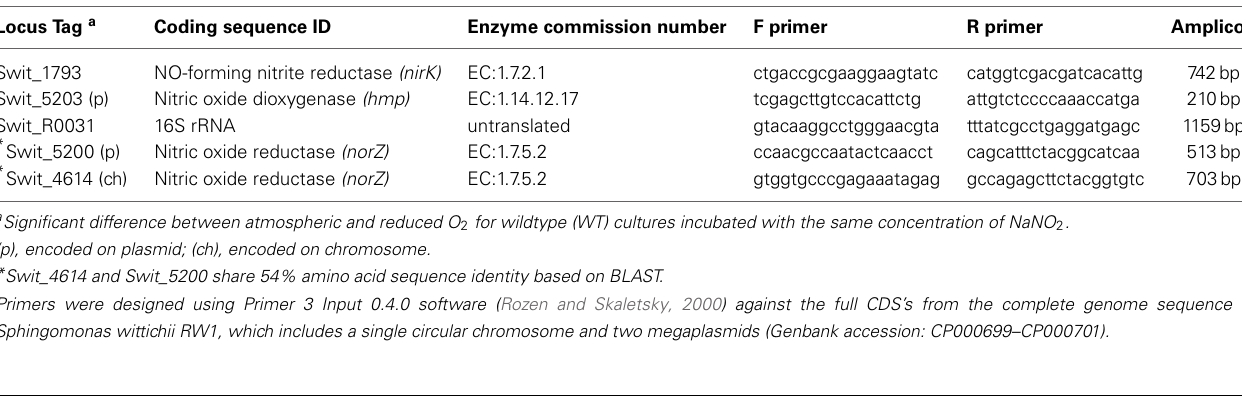
Table 1 | Primers used to generate probes for RNA dot-blot